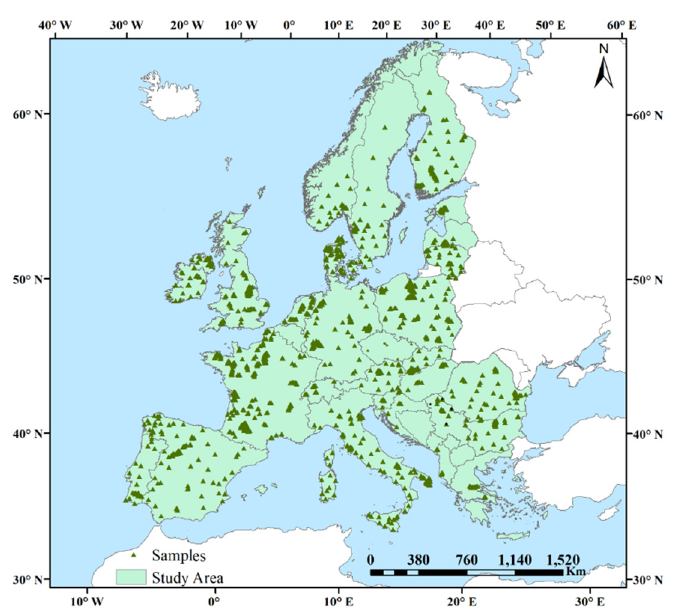
Figure 1. The study area, encompassing 32 countries across Europe. The green triangles show the field survey samples from Google Earth Engine.